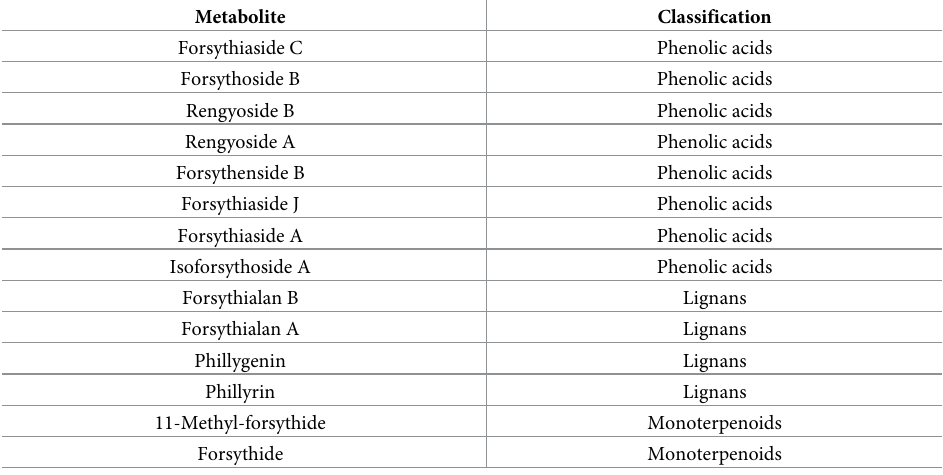
Table 3. Classification of the Forsythia related